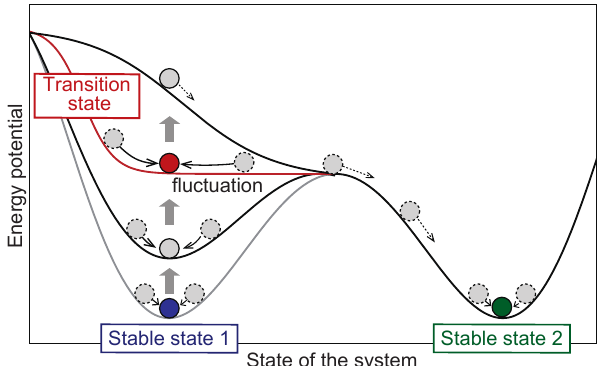
Figure 1. A conceptual diagram of the DNB